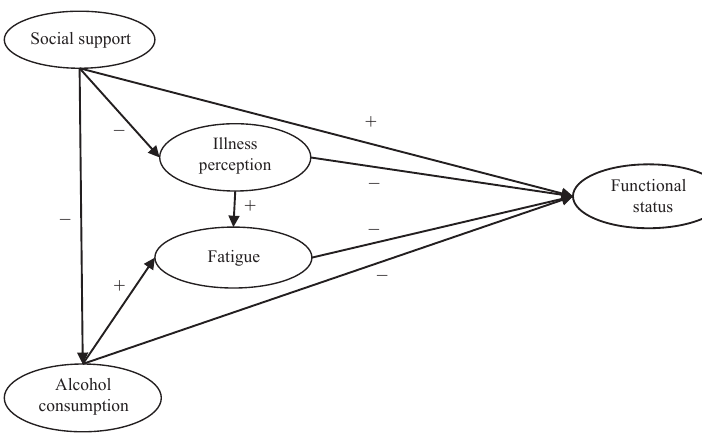
Figure 1. Hypothesized model